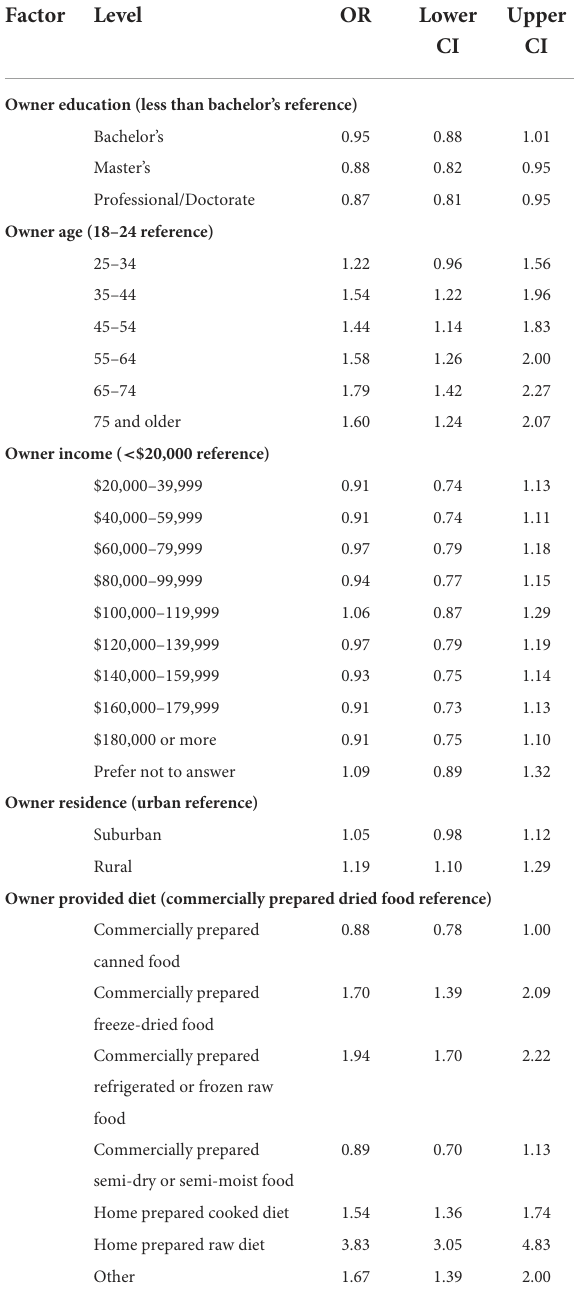
TABLE 1 Odds ratios and 95% confidence intervals for owner demographic factors on joint supplement use in dogs. Factor Level OR Lower